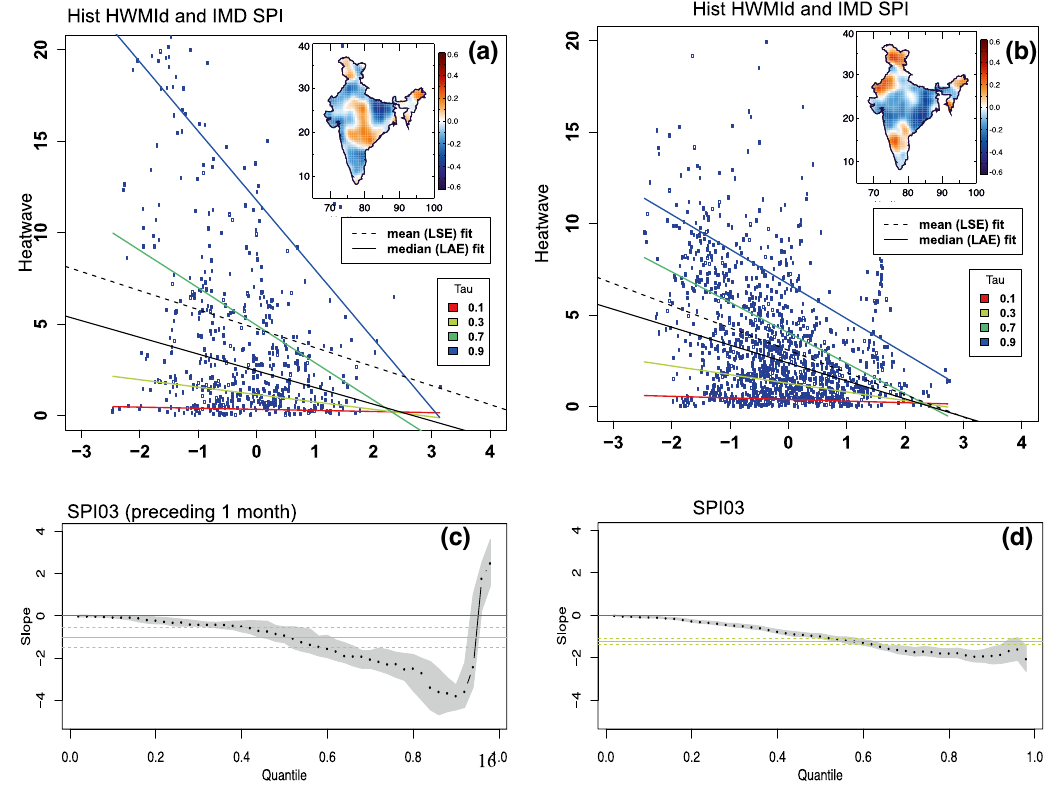
Figure 3. Quantile regression analysis between heat waves and 3-month standardized precipitation index (SPI03) using data from all grids. Scatter plots of the maximum HWMId values for each grid location over India during the period 1961–2015 and the 3-month SPI preceding 1 month ( a ) and concurrent month ( b ). Inset figures display the spatial correlation maps of HWMId- SPI03. Panels ( c ) and ( d ) show the corresponding regression slopes for 0.1–0.99 quantiles of the maximum HWMId-SPI03. Black filled circles indicate the regression slope for different quantiles and shading indicates the associated uncertainty. The horizontal solid line represents the mean trend based on the ordinary least-squares method. (Figure was created using the Interactive Data Language (IDL) version 8.2 software, http:// www. harri sgeos patial. com/ docs/ whats_ new_ in_ 82.